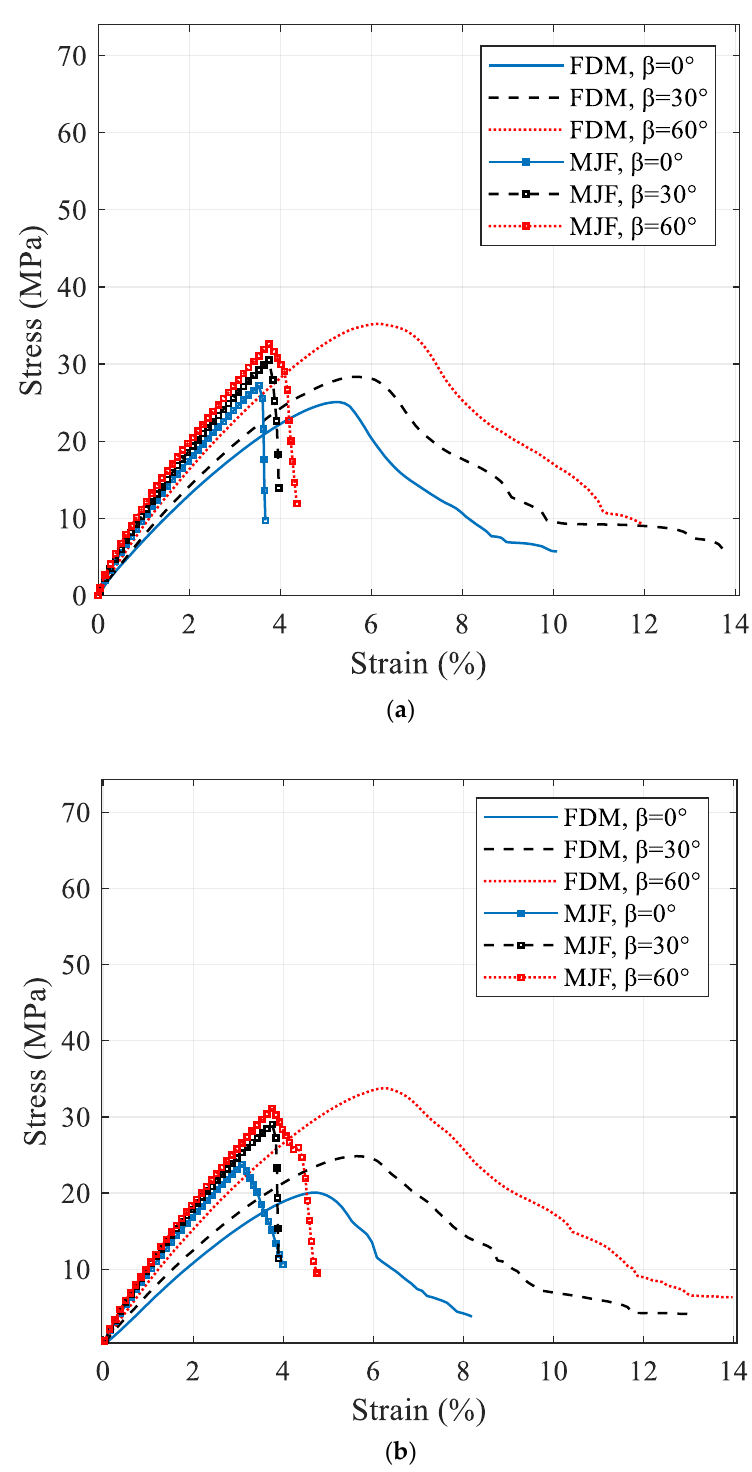
Figure 6. Standard tensile stress – strain curves for the FDM and MJF 3D-printed nylon; ( a ) 𝑟 = 1 mm, ( b ) 𝑟 = 2 mm .